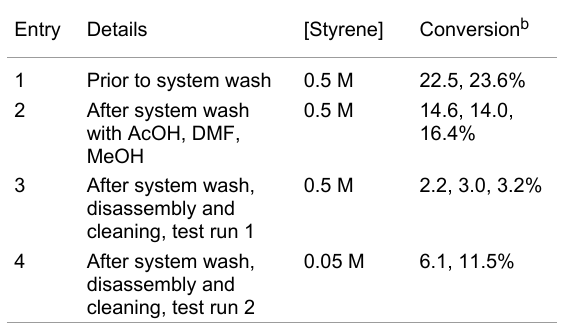
Table 2: Background reduction of styrene to ethylbenzene caused by catalyst contamination on the SAH 3 system.